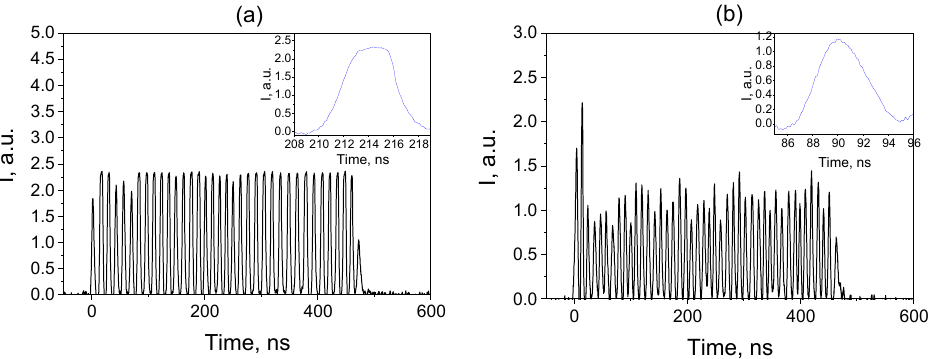
Figure 7. Output pulse shapes of the 1st Stokes (1018 nm) ( a ) and the 2nd Stokes (1064 nm) ( b ) waves at 40 W pump power in the RFL with fiber pigtailed AOM. Insets: individual sub-pulse shapes.